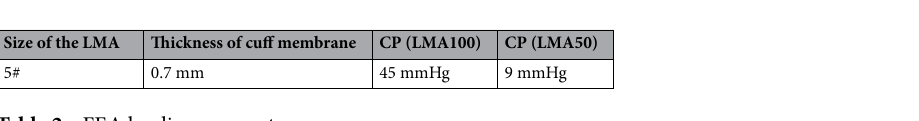
Table 2. FEA loading